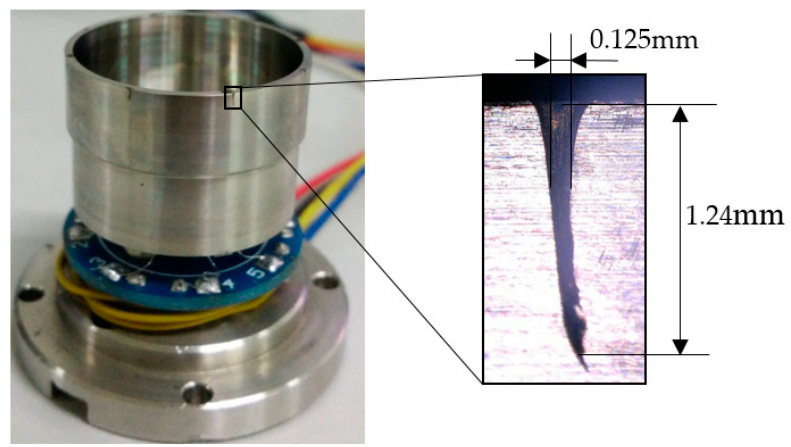
Figure 14. Forming grooves on the top edge of the wall in the experiment.